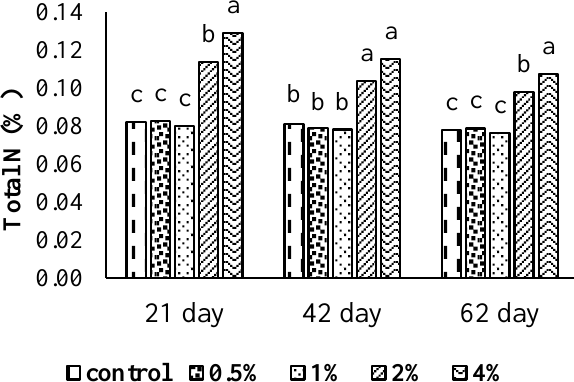
Figure 5. Effects of different rates of HA applications on total ni-